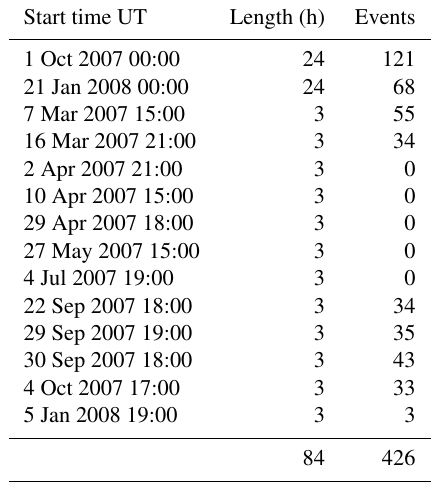
Table 1. Investigated data intervals and events in 6s resolution data.